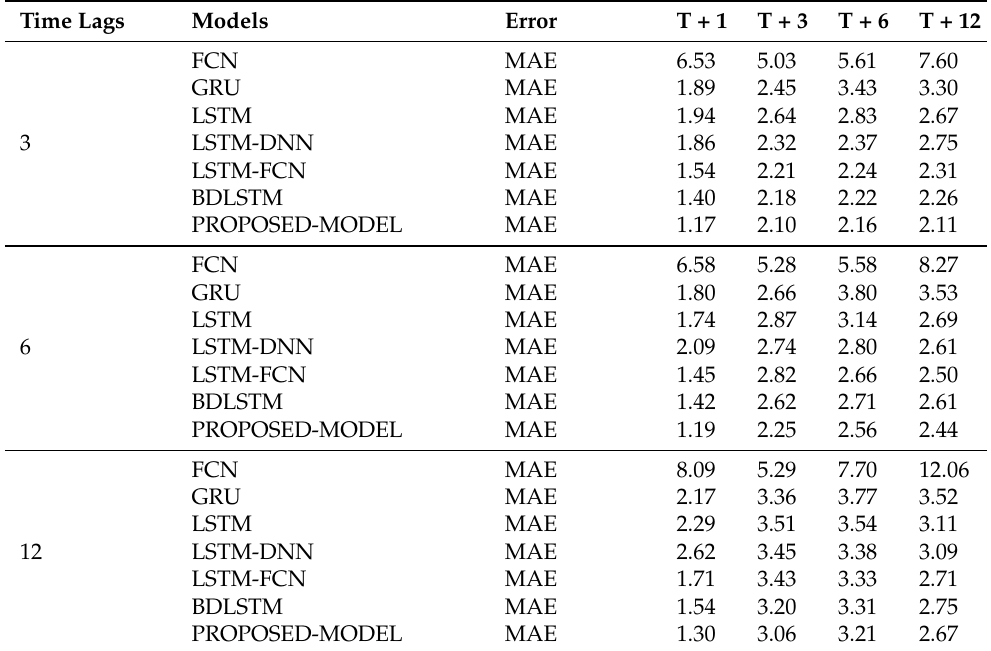
Figure 10. Performance prediction of the proposed model on different time lags. Table 2. Comparison with baseline